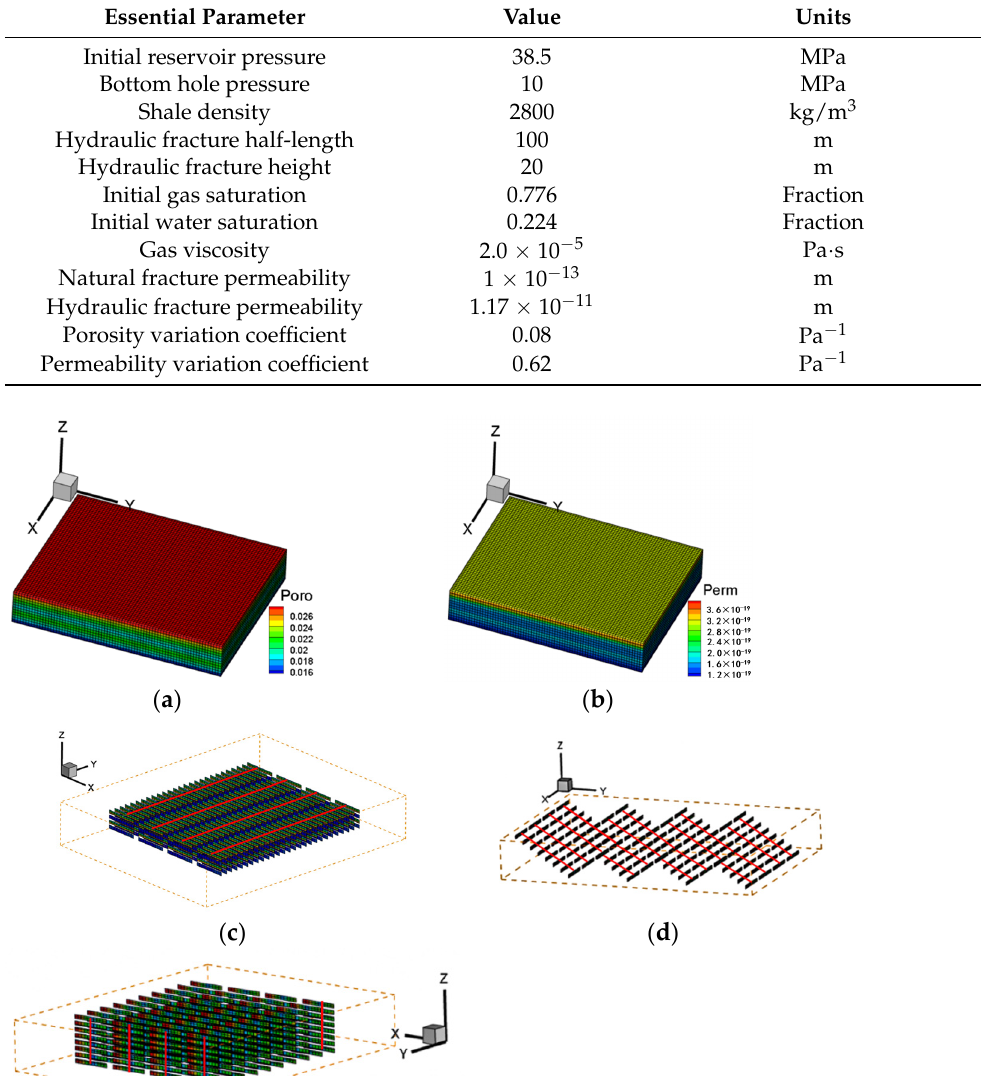
Table 3. Well and hydraulic fracture related parameters.